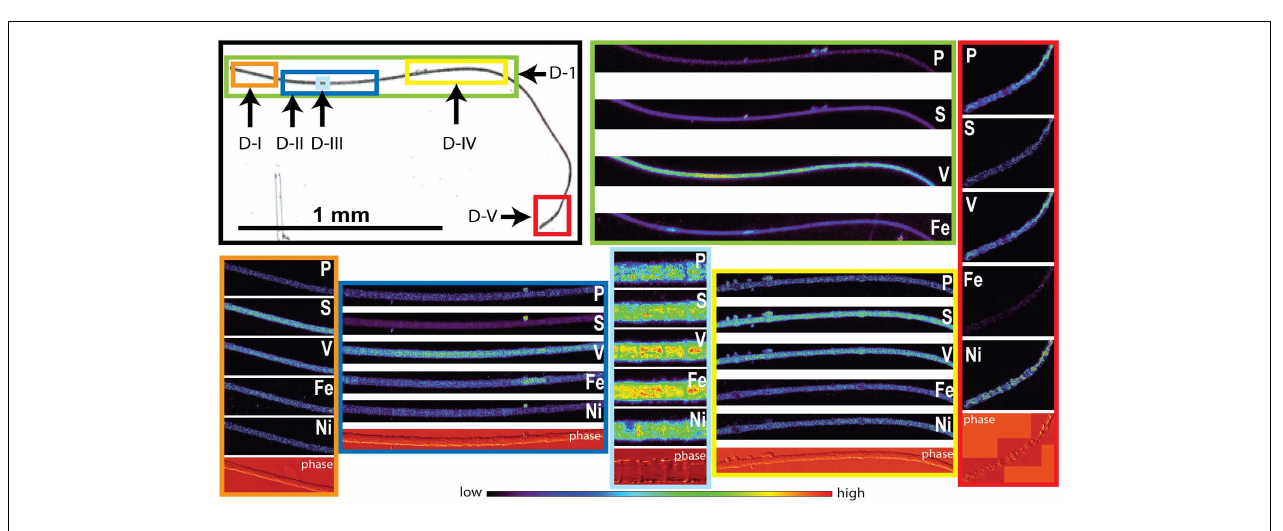
does not follow the color scale for the element maps.The location of each trichome section is indicated on the light micrograph with a unique outline color. MAP D-1 (green) was recorded at the GSECARS beamline, while maps D-I (orange), D-II (dark blue), D-III (light blue), D-IV (yellow), and D-V (red) were recorded at